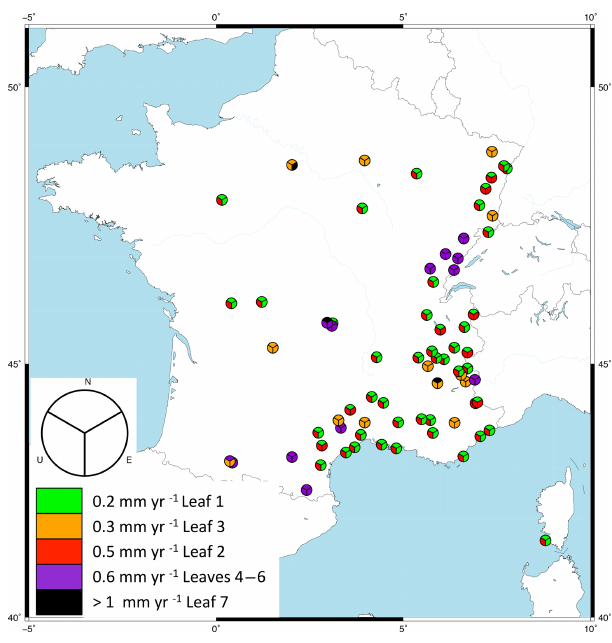
Figure 9. Map of the RENAG stations with the v 95 velocity bias of each component according to the tree